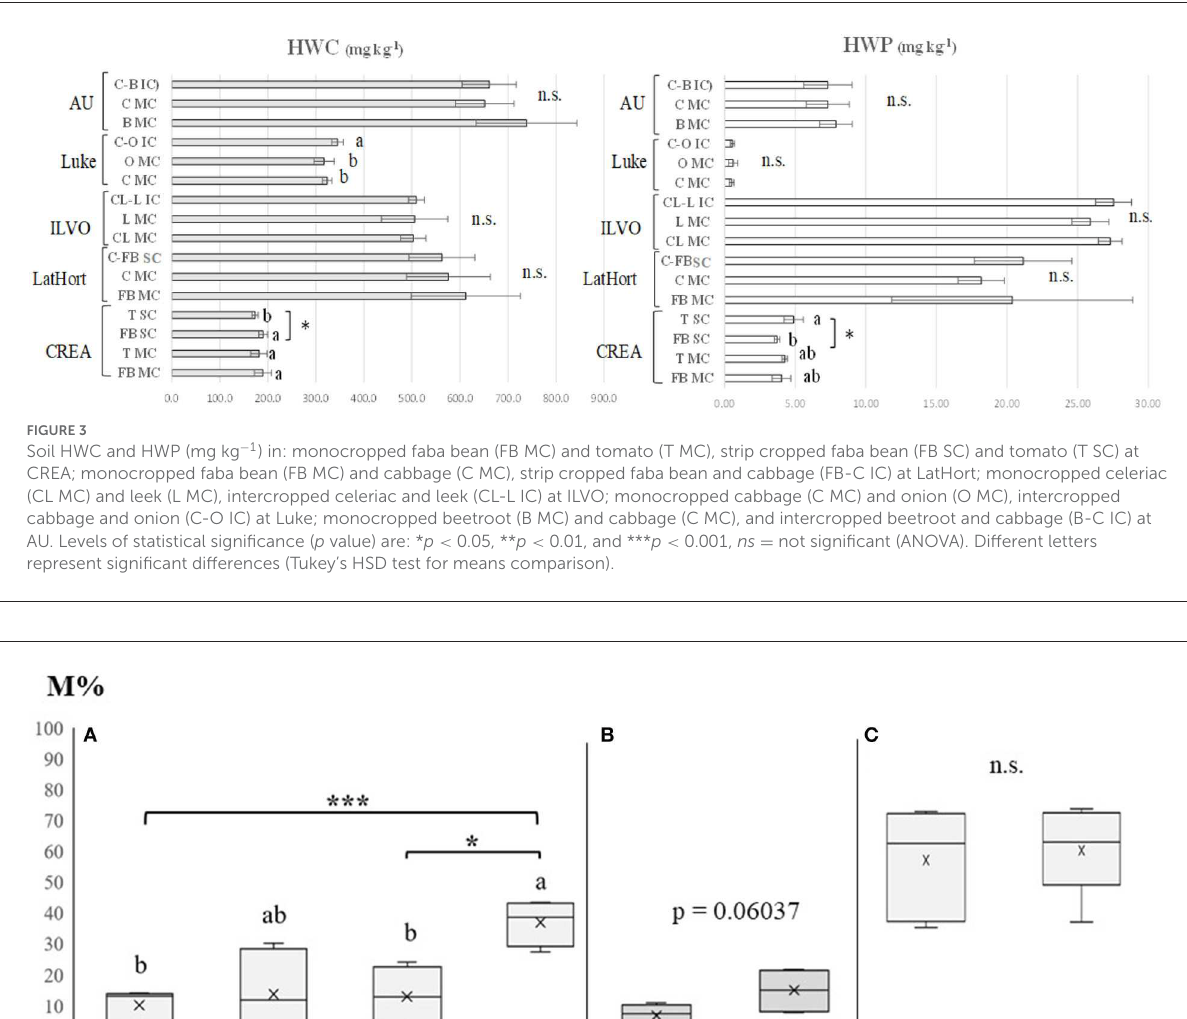
(29.5% in MC and 23.5% in SC, respectively; p = 0.0491) and Bacteroitedes (13.5% in MC and 18.7% in SC) (Figure